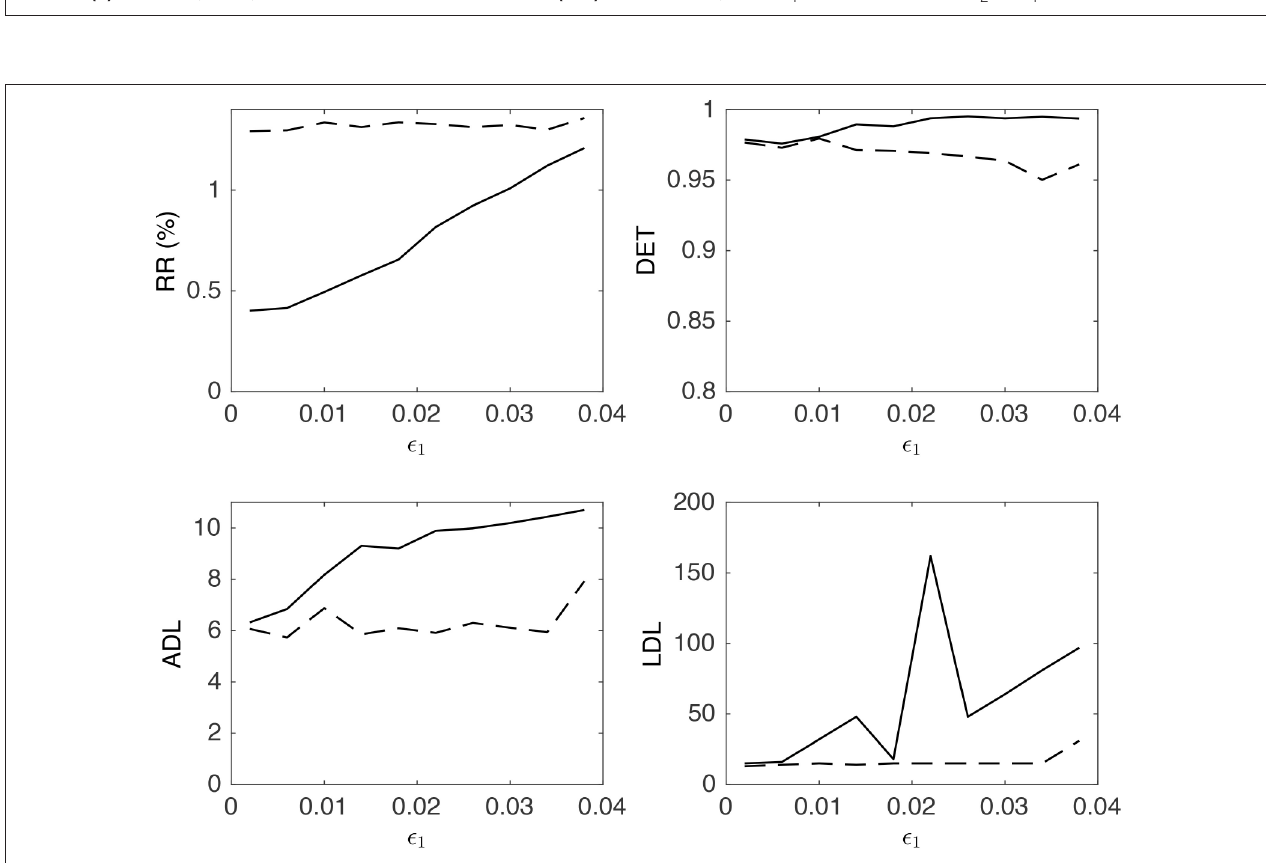
FIGURE 5 | Recurrence measures RR, DET, ADL, and LDL for CRQA (dashed lines) and MdRQA (solid lines) as a function of the coupling constant ǫ 1 .